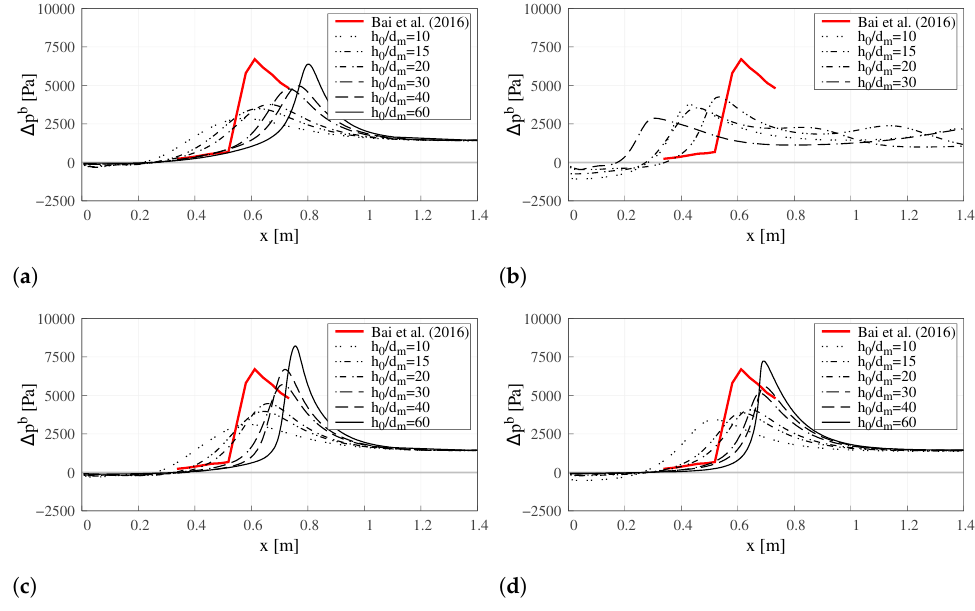
Figure 7. Pressure increment along the spillway bottom. ( a ) TPVoF , k – (cid:101) . ( b ) CTPE , k – (cid:101) mixture . ( c ) TPVoF , k – ω SST . ( d ) CTPE , k – ω SST Sato